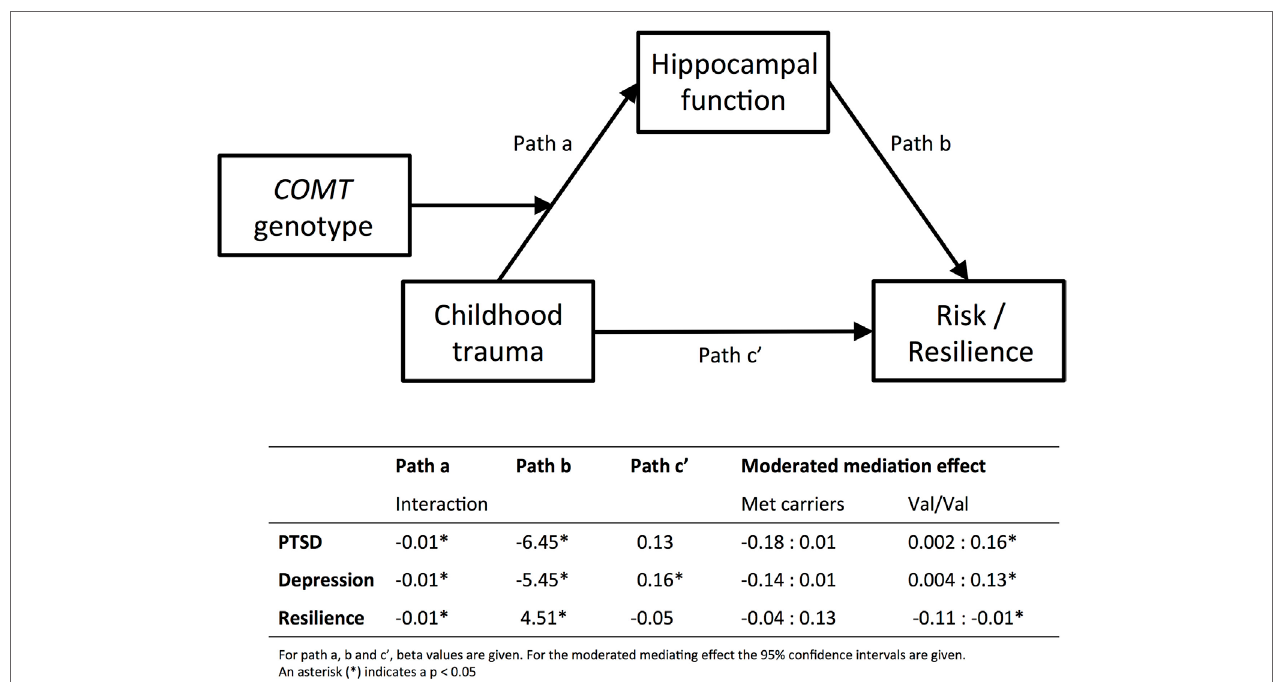
FigUre 3 | Moderated mediation analyses . Results from the moderated mediation analyses are displayed. The top panel shows the model and the bottom part shows the corresponding beta values for path a, b and c ′ , separately for PTSD, depression, and resilience. Path a corresponds to the results presented in Figure 1 , and shows that COMT genotype moderates the effect of childhood trauma [measured with CTQ, Childhood Trauma Questionnaire (37, 38)] on inhibition-related hippocampal activation. Path b corresponds to the results displayed in Figure 2 , hippocampal function predicts PTSD [PSS, Modified PTSD Symptom Scale (40)], depression [BDI; Beck Depression Inventory (41)], or resilience [CD-RISC, Connor–Davidson Resilience scale (42)]. For the moderated mediation analysis, the 95% confidence intervals are given in the table. The effect of childhood trauma on psychiatric risk or resilience is mediated by hippocampal function, but only in the Val/Val group. Finally, Path c ′ shows that childhood trauma only directly predicts depression